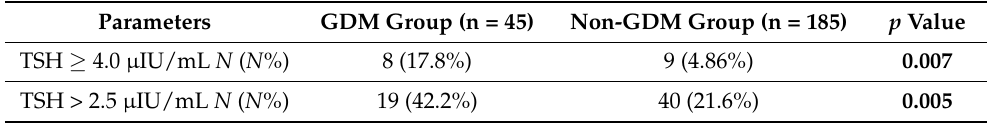
Table 5. The prevalence of elevated TSH in the study population.